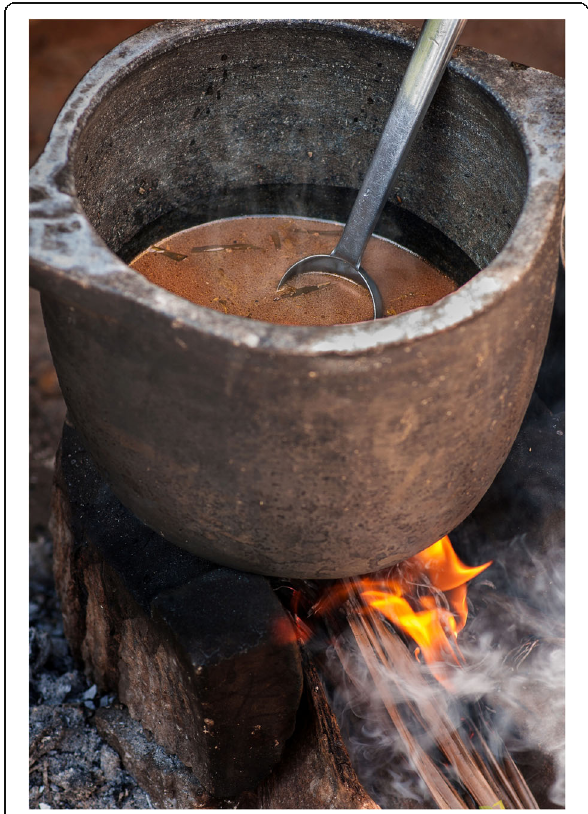
Fig. 5 The liquid based, sour, acidic, tamarind containing food item